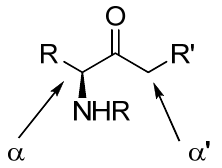
Figure 3. Easily enolizable positions in amino